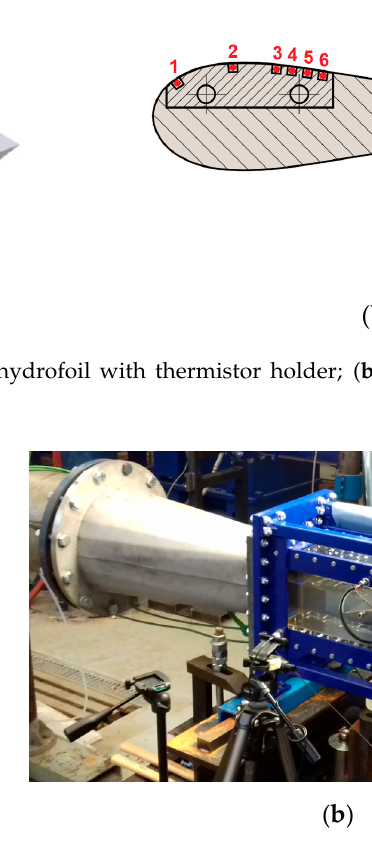
Figure 10. ( a ) Thermistor probes on upper side of hydrofoil; ( b ) picture of cavitation tunnel test section. test